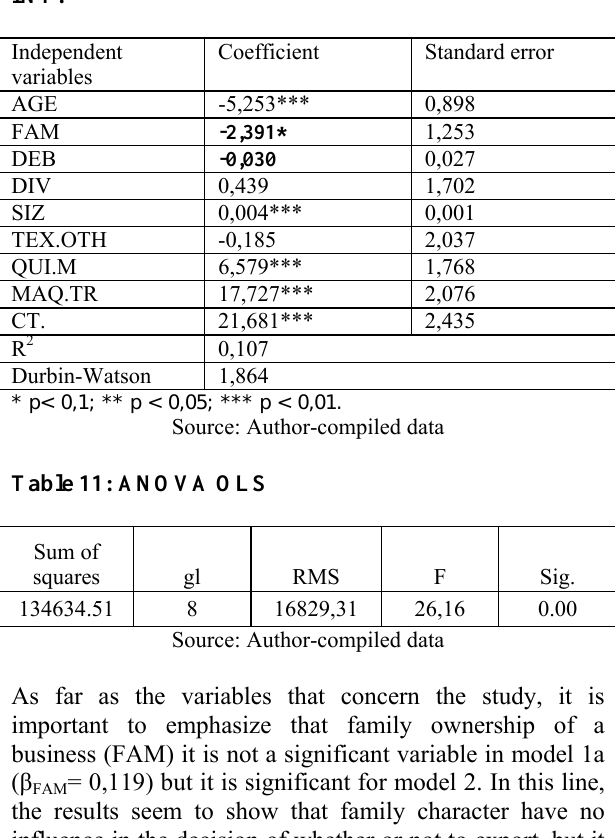
Table 10: OLS Analysis. Model 2.Dependent variable INT.